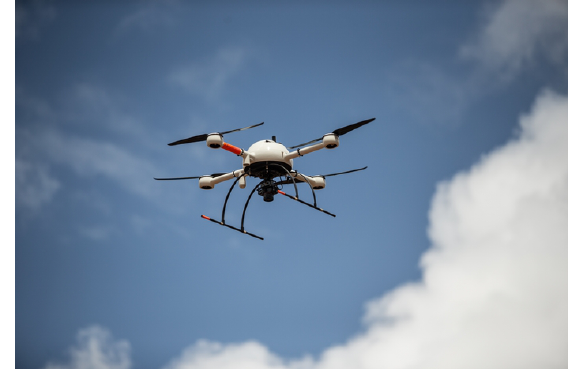
Figure 1. A Microdrones md4-1000DG system with Sony RX1-RII camera and APX-15 direct geo-referencing